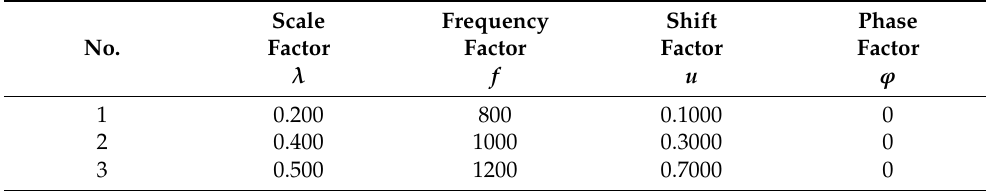
Table 4. Time–frequency factors of S 1 with the traditional method.